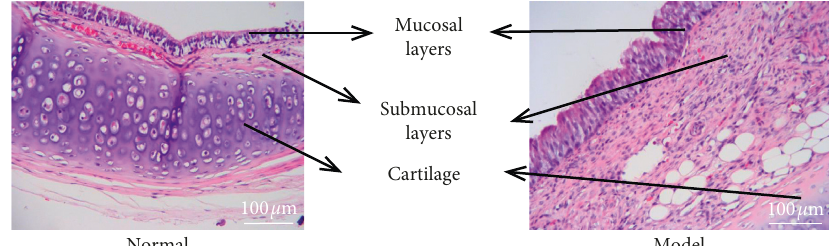
Figure 1: Pathological results. There was no hyperplasia of trachea tissue in Normal group, while bronchial cavity stenosis, tissue hy- perplasia and mucosal epithelial hyperplasia were observed in the model group.